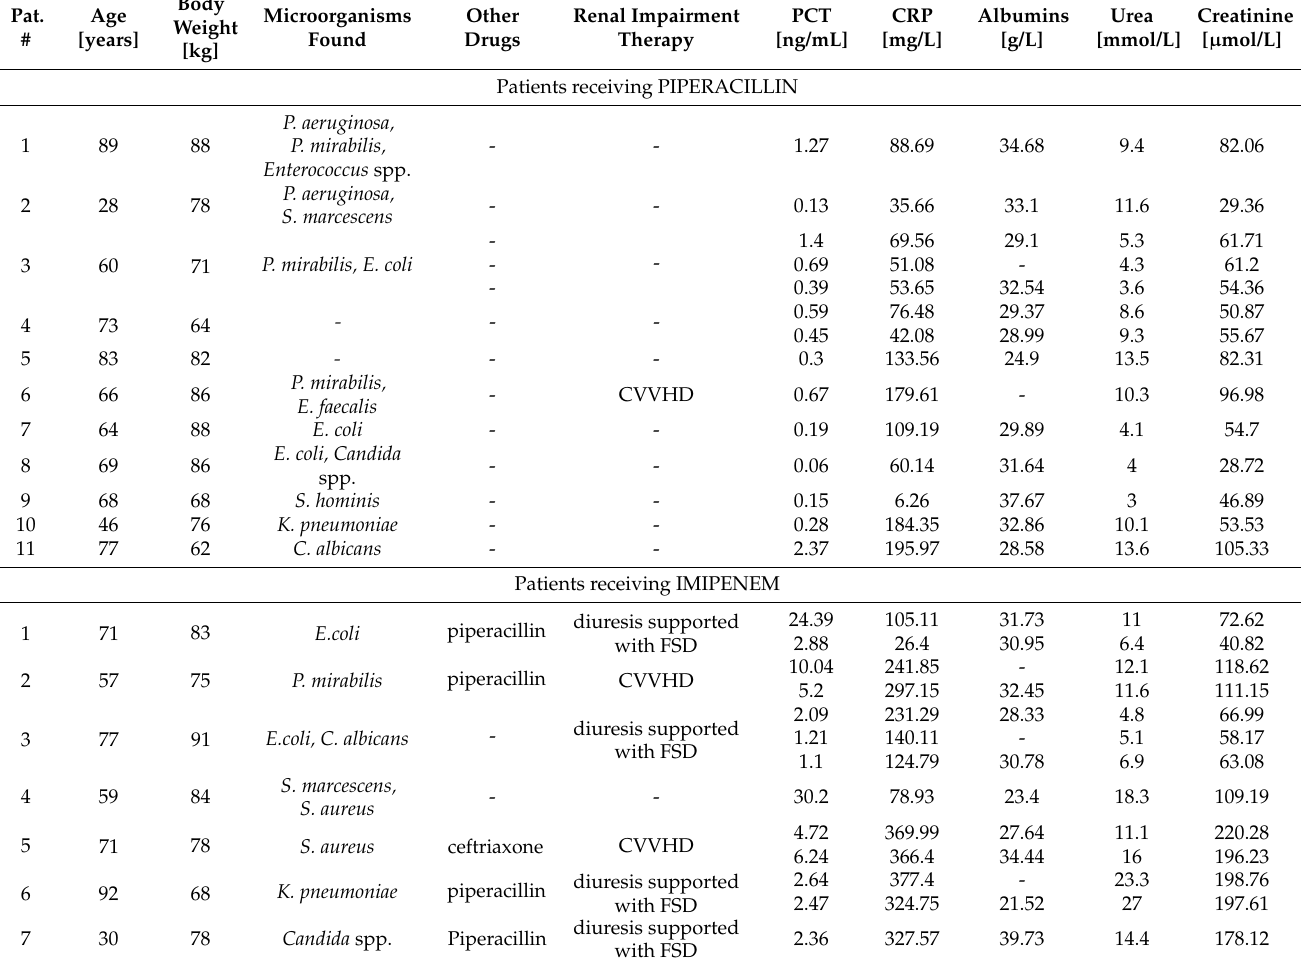
Table 6. Characteristics of patients included in blood sampling. Other antibiotics are considered only if administrated within one week before sample collection. PCT—procalcitonin